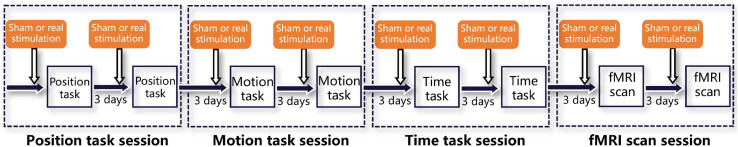
Experimental procedures. The whole experiment consisted of four sessions, i.e., a position task session, motion task session, time task session, and fMRI scan session. Each session was separated from the previous one by 3 days to eliminate aftereffects and included two tasks or scans, also separated by 3 days. Immediately before both tasks or scans, sham and real stimulation were delivered, in random order.